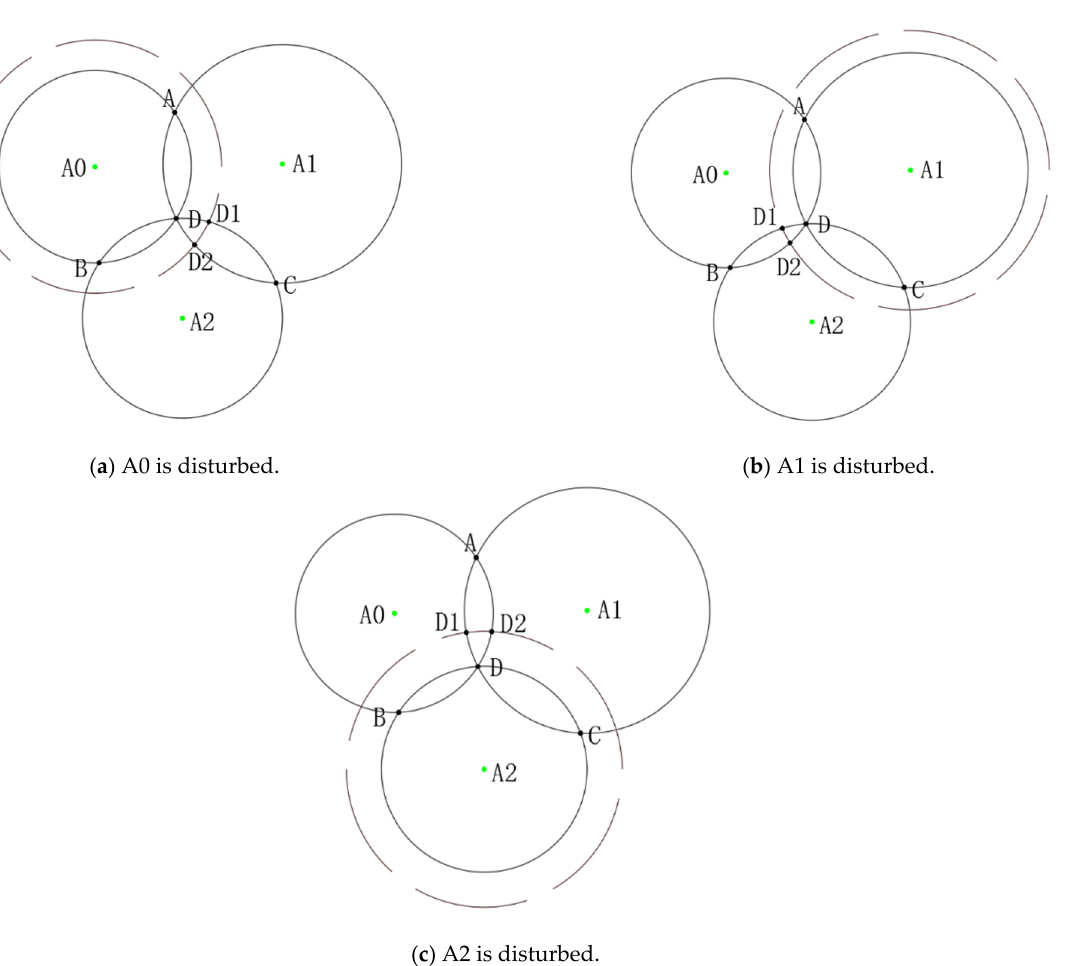
Figure 10. Any anchor point in a two-dimensional space is disturbed (The letters on the figure indicate the centers of the three circles or the points of intersection on the circles).